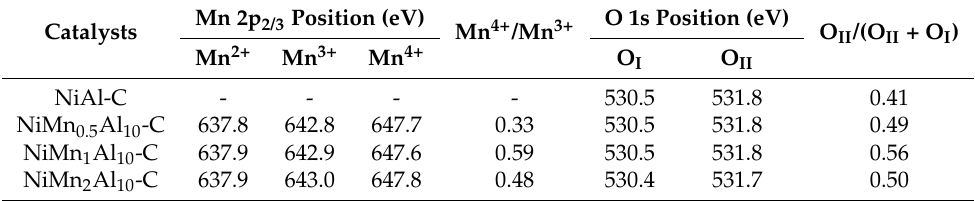
Table 3. Surface valence of catalysts determined by XPS.